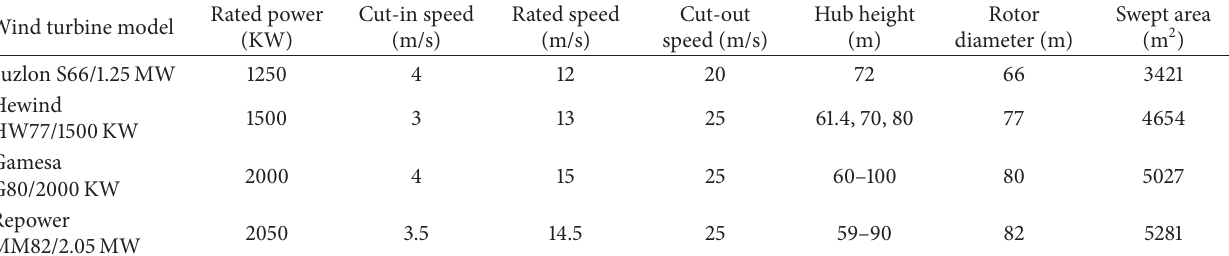
Table 2: Technical data of nominated wind turbines [19–22].